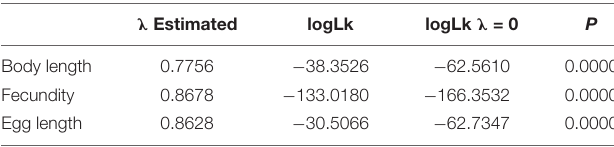
TABLE 1 | Phylogenetic signal of each trait obtained with univariate